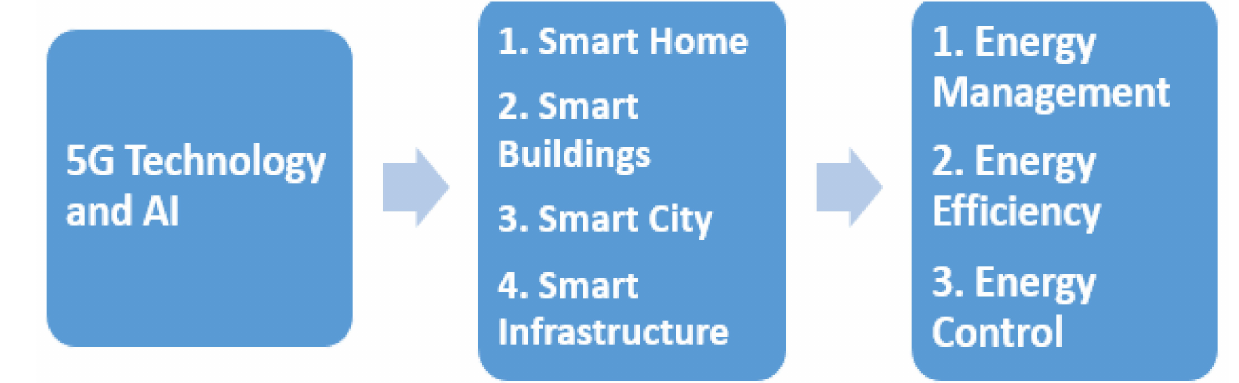
Figure 1. The 5G and AI applications in smart buildings